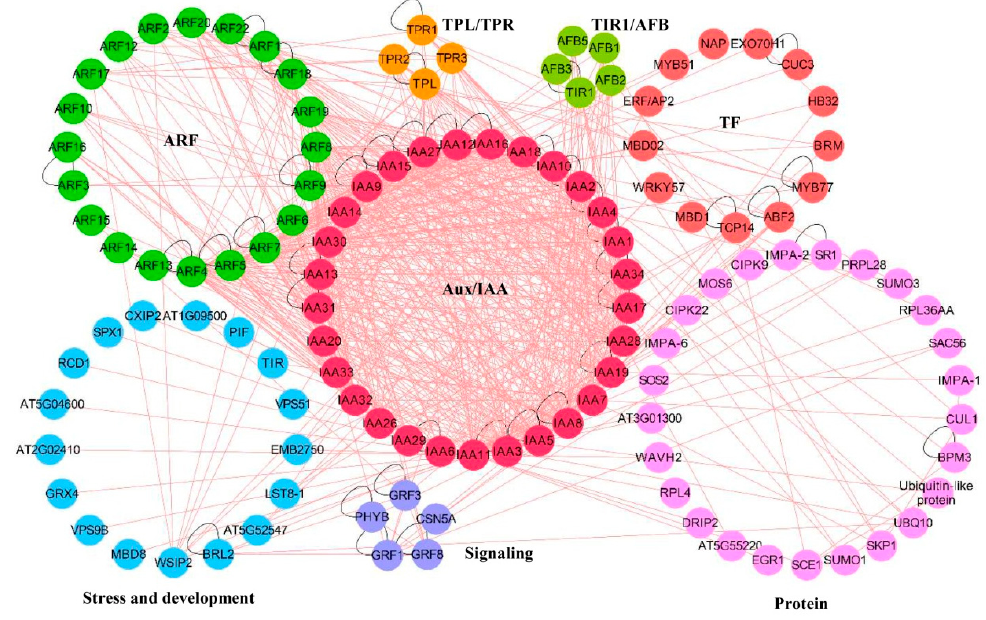
Figure 2. Aux/IAA protein interaction network. The physical protein–protein interactions were obtained from the BioGRID database (v3.4.153, https://thebiogrid.org/) [76] and visualized in Cytoscape (version 3.5.0) [77]. The Aux/IAA, ARF, TPL/TPR and TIR1/AFB proteins were identified